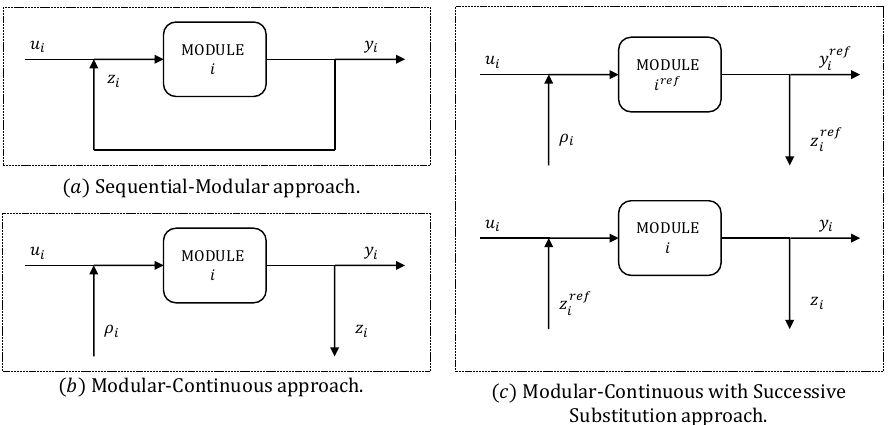
Figure 1. Schemes of the modeling approaches: ( a ) Sequential Modular; ( b ) Modular Continuous; the proposed ( c ) Modular Continuous with Successive